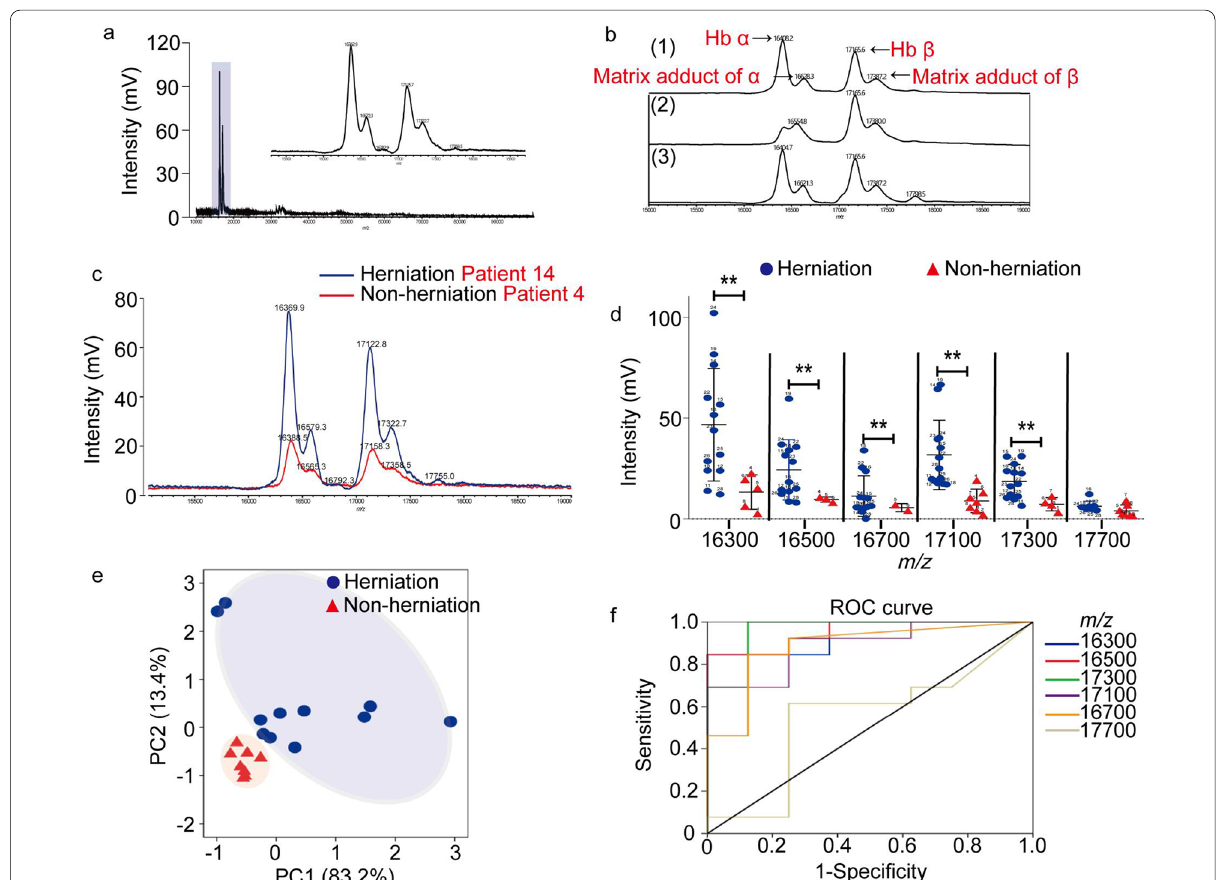
MS spectra of total protein lysates measured by a high-mass detector. The tissue sample was obtained from the patient 24 in Table 1. b The spectra of Hb standard (1), tissue lysates (2), and a standard and lysate mixture (3) measured by the high-mass detector. The tissue sample was obtained from the patient 23 in Table 1. c The spectra of tissue lysates from herniated nucleus pulposus and nonherniated nucleus pulposus measured by a high-mass detector. The tissue samples were obtained from the patients 14 and 4 in Table 1. d Scatter plot of the Hb-related peak intensity in 13 samples of herniated nucleus pulposus and 9 samples of nonherniated nucleus pulposus as measured by a high-mass detector. The data were analyzed with GraphPad Prism 5.02 software. **P < 0.01. e The PCA clustering diagram of 13 samples of herniated nucleus pulposus and 9 samples of nonherniated nucleus pulposus. f ROC curve analysis of 6 Hb-related peaks in 13 samples of herniated nucleus pulposus and 9 samples of nonherniated nucleus